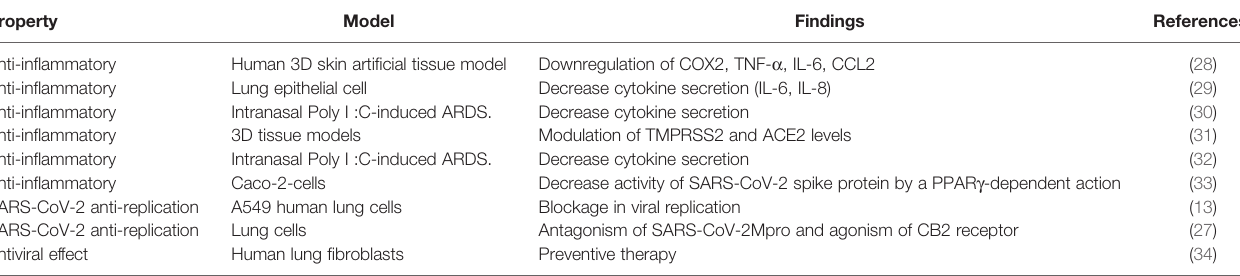
TABLE 1 | Actions of CBD use in different preclinical studies in COVID-19.